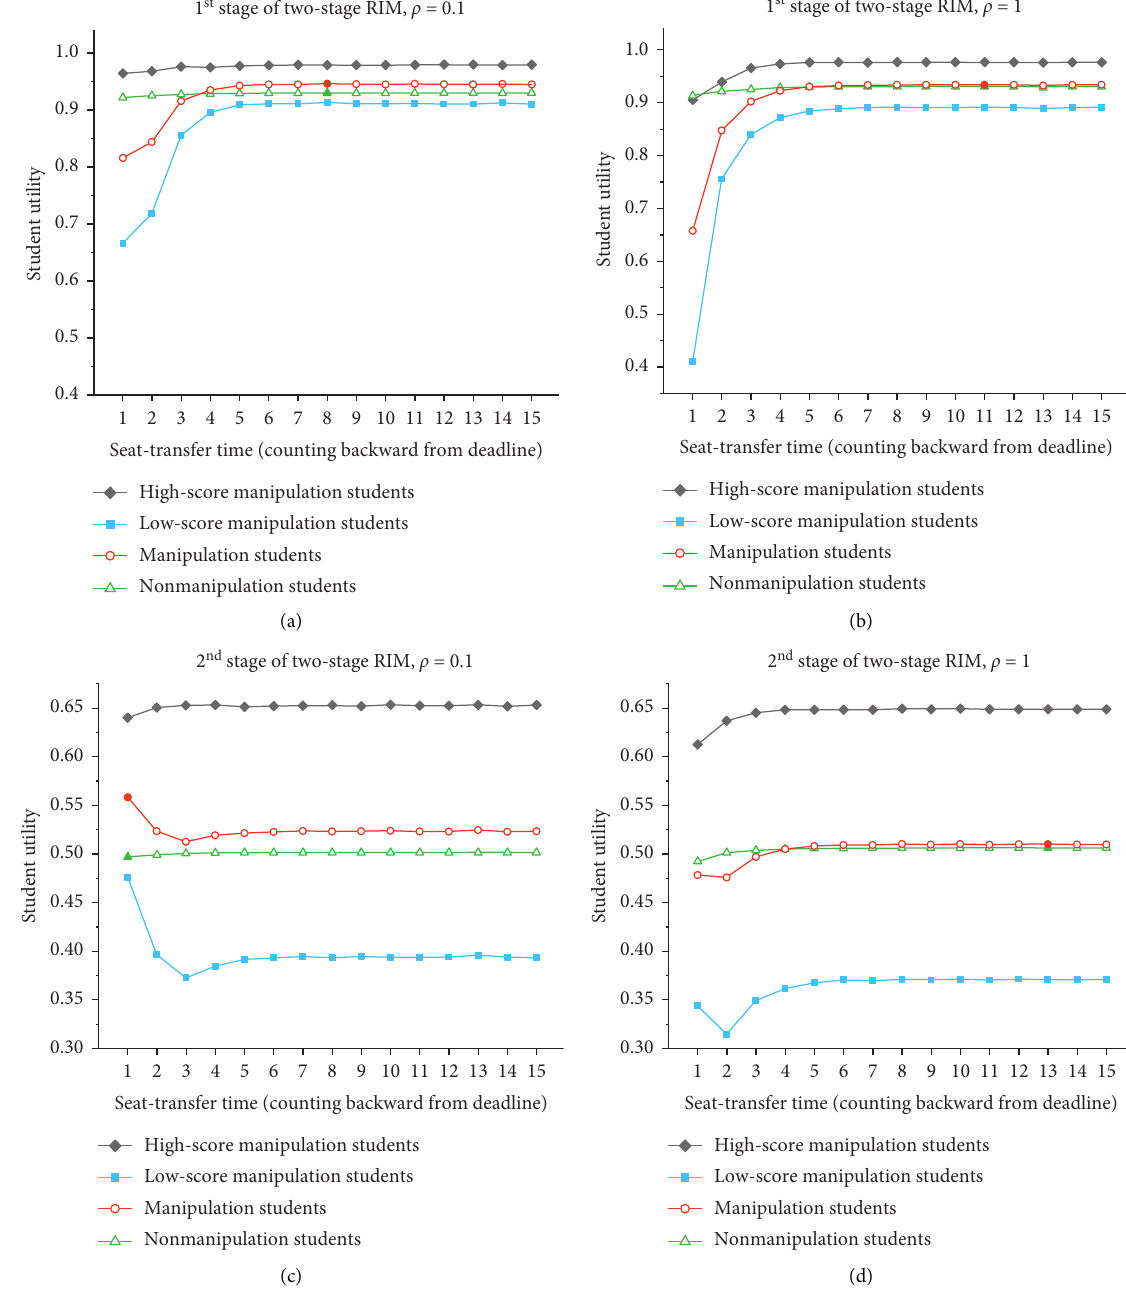
Figure 5: Utilities of manipulation and nonmanipulation students under different manipulation-seeking ratios ρ under two-stage of RIM. The utility of manipulation students is always larger than that of nonmanipulation students for different values; hence, the steady state is that all students are willing to conduct coordinating